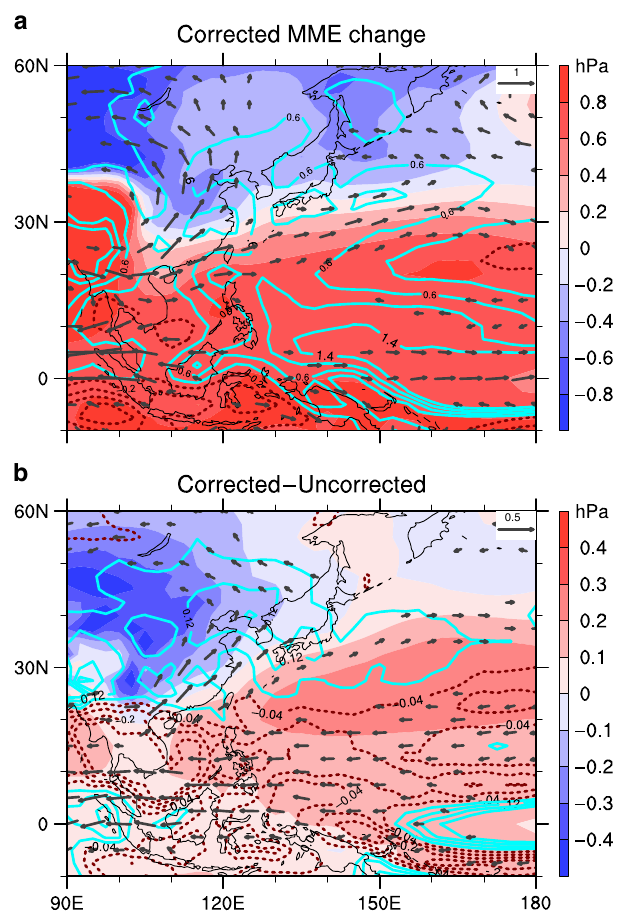
Fig. 4 Corrected projections and differences from the uncorrected. a Corrected sea level pressure projection (shadings; hPa) and related changes in 850 hPa wind (vectors drawn for larger than 0.2 m s − 1 ) and precipitation (contours; mm day − 1 ) over the western North Paci fi c region in the multi-model ensemble mean (MME) based on the best-estimated principal components (see details in “ Methods ” ). b The difference between corrected and uncorrected results, which is reconstructed by the two constrained leading uncertainty modes (Supplementary Fig. 5). Corrected results show an enhanced western North Paci fi c Subtropical High, stronger monsoon circulation, and rainfall band in East Asia which